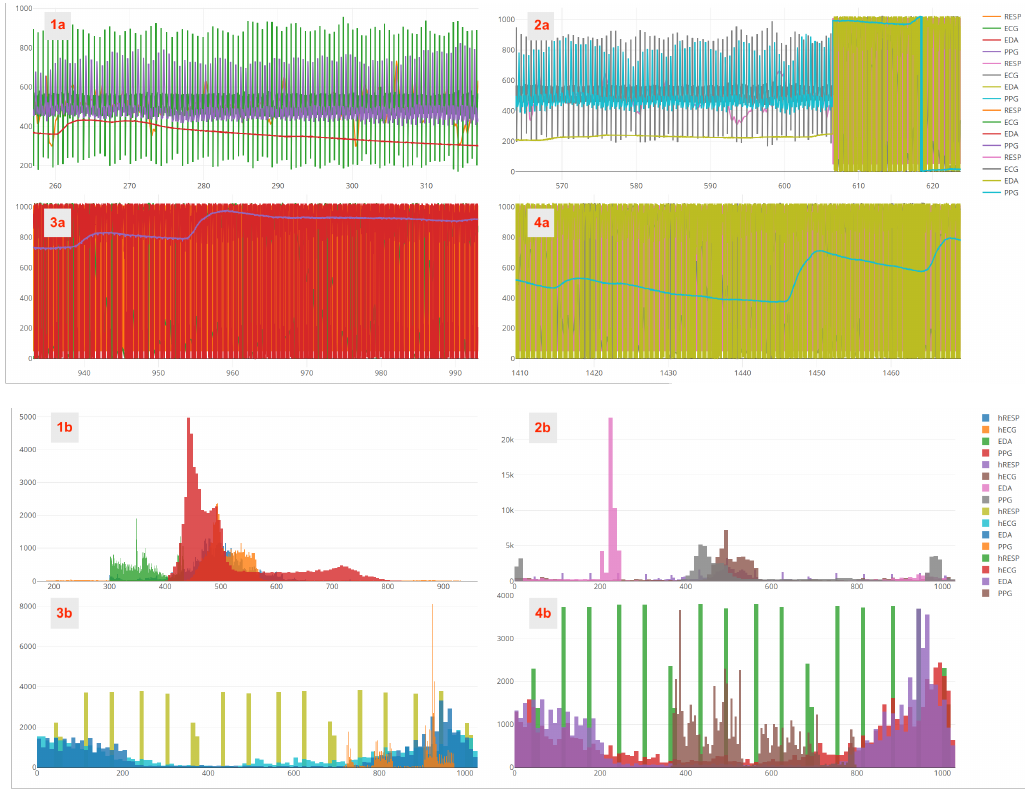
Figure A2. Plots ( top — 1a – 4a ) and corresponding histograms ( bottom — 1b – 4b ) of the psychophysiological signals acquired in four different moments ( 1 – 4 ) during one of the sessions of one assessor. It is possible to observe in the plots at the top that in the first moment ( 1a ) the signals are valid, in the second moment ( 2a ) a failure appears by the end of the acquisition, and in the last moments ( 3a , 4a ) the signals are invalid. From the histogram (bottom), it is possible to observe that, in the first moment ( 1b ) when the signals are valid, these are concentrated around a central point; in the second moment ( 2b ), the partial signal failure distorts the histogram by reducing the density at central frequencies and a high-frequency component appearing, while in the last moments ( 3b , 4b ) when the signals are invalid, these are dispersed. It was based on this that 3 different clusters (at 20%, 50% and 90% of full scale) were created in order to test the validity of the